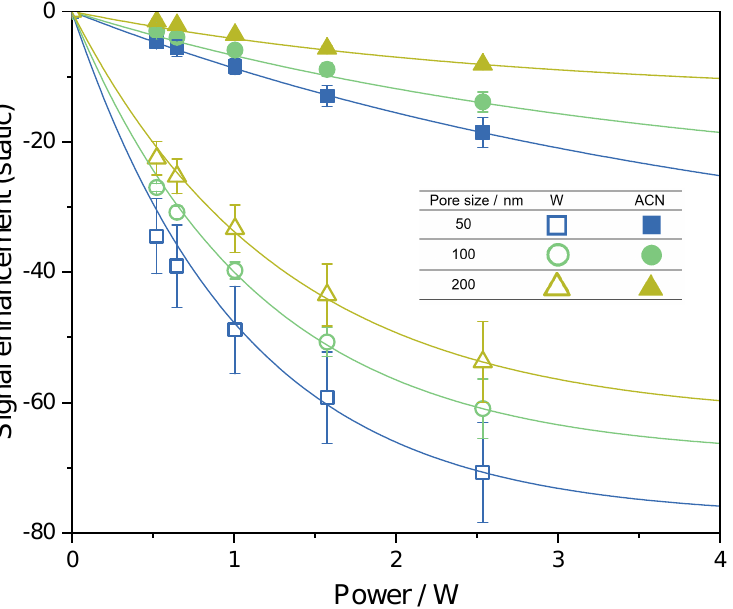
Figure 3. Results from static ODNP measurements with water (W) and acetonitrile (ACN) obtained with CPG-PEI25000-GT of different pore sizes and different applied microwave power values. The symbols are experimental results and were obtained as the arithmetic mean of the measurements of five individual samples. The error bars indicate the standard deviation. Solid lines: extrapolation to infinite microwave power